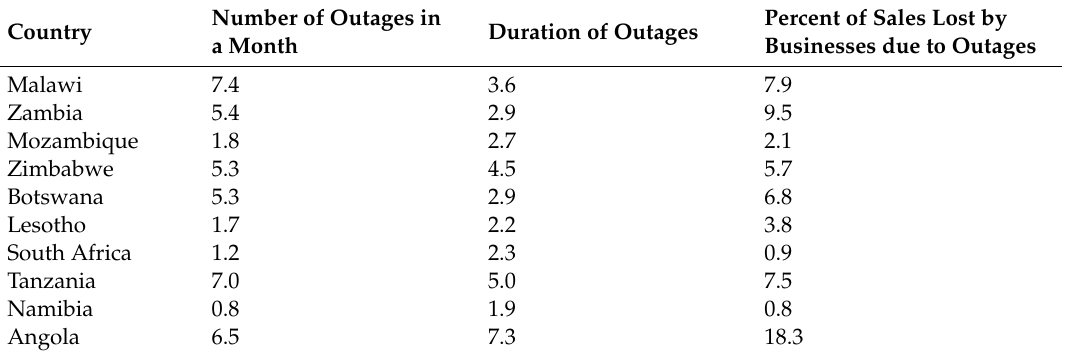
Duration of Outages